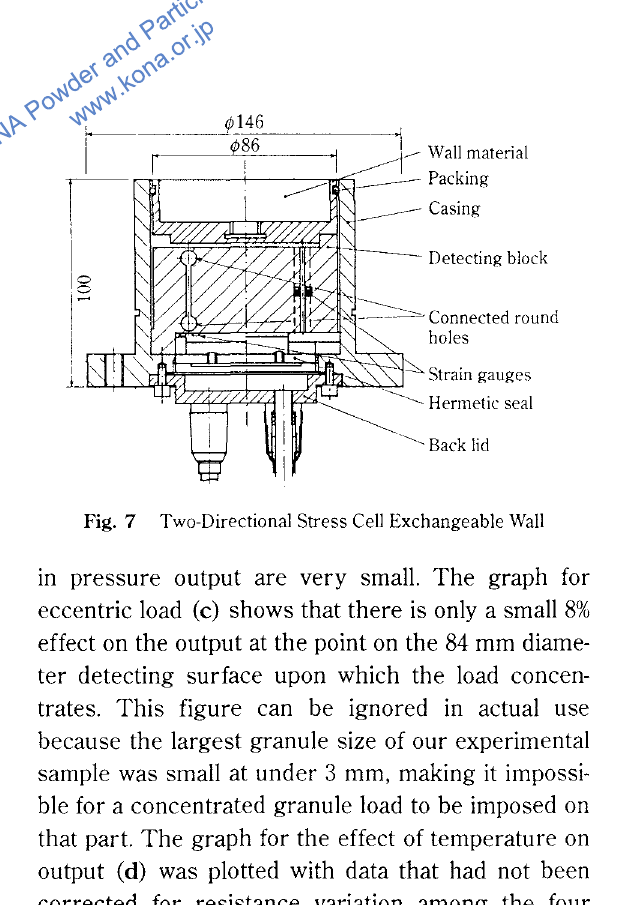
Detecting Principle of Deformation Sensor